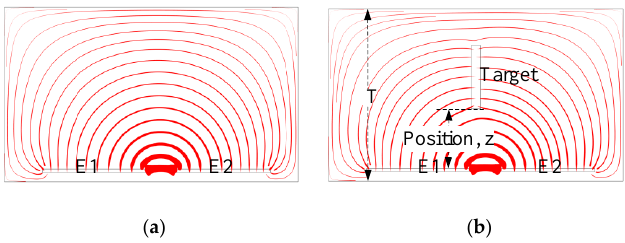
Figure 2. Schematic of electric field lines without a target ( a ) and with a target ( ε T “ 52) ( b ). The setting of the boundary conditions in the simulation are as follows: the dielectric of the electrodes and the target are 100 and 52, respectively; the electrical potential of the driving electrode and the sensing electrode are 5 and 0 V; the air boundary was defined as zero charge.